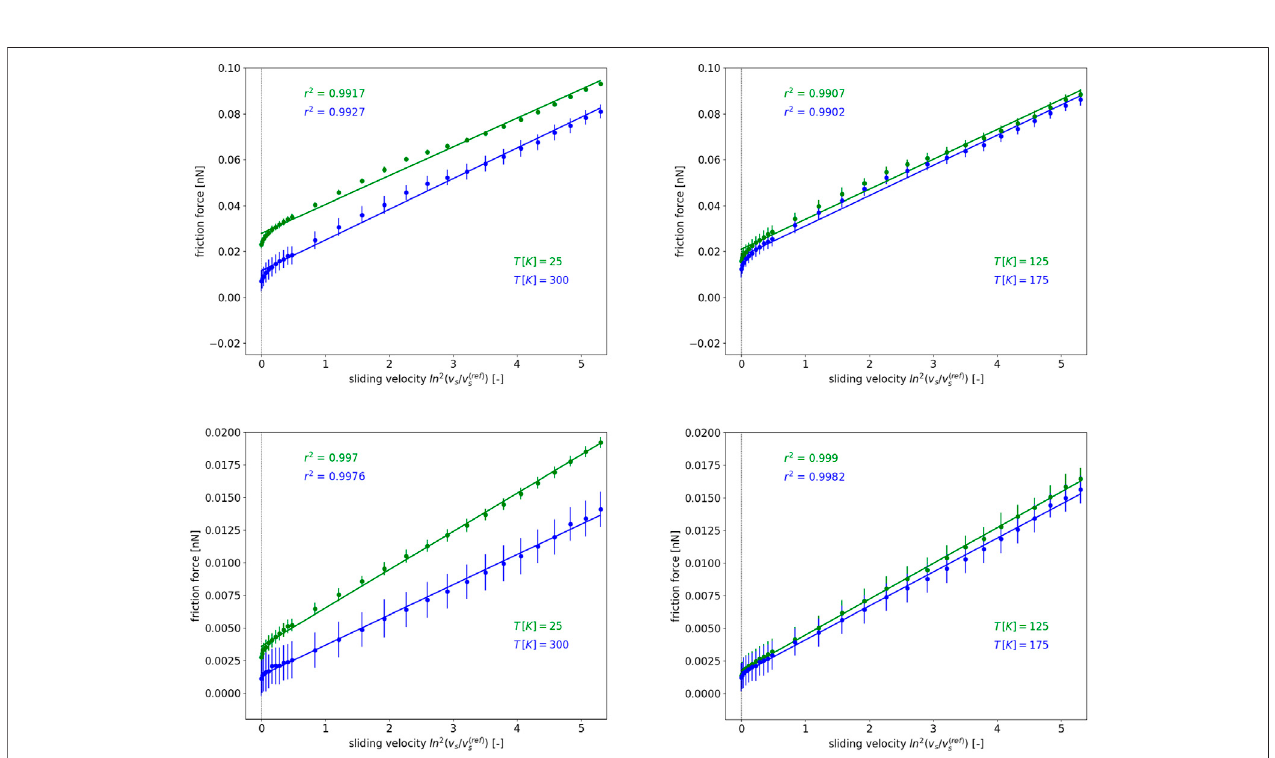
FIGURE 10 | As in Figure 9 , but within the superlubric frictional regime.